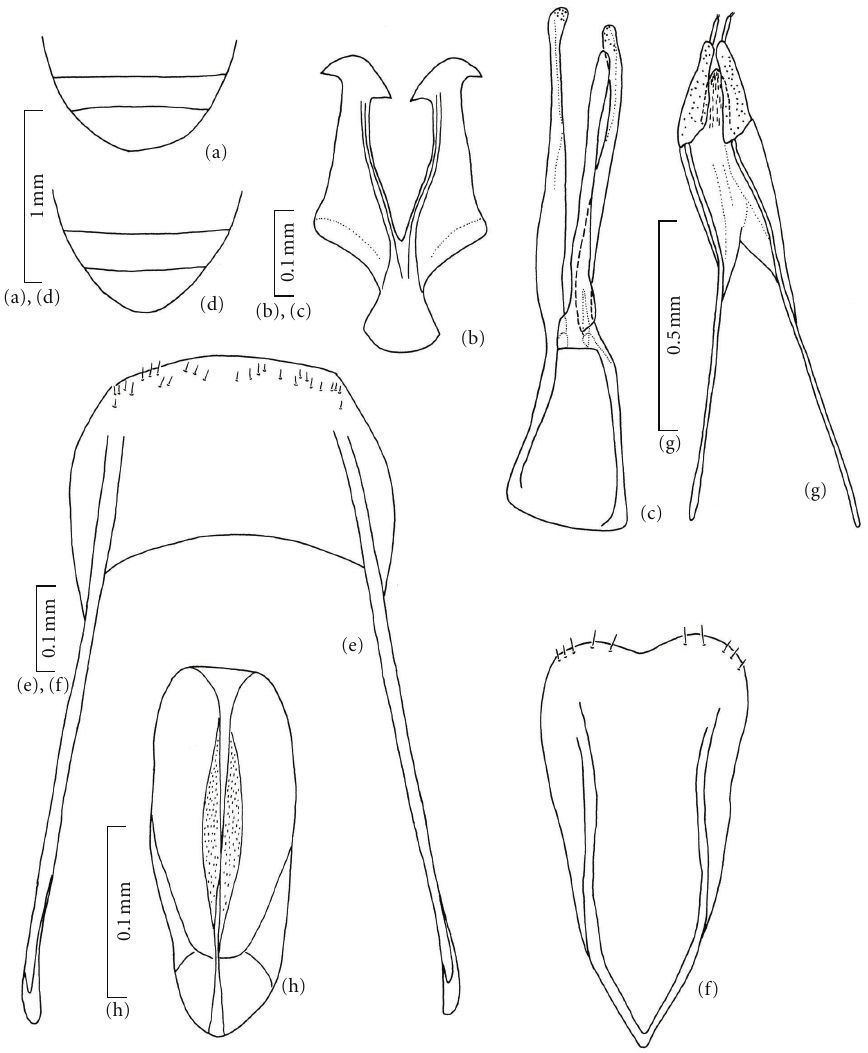
Figure 2: Hydrocyphon jogjaensis sp.n., holotype, male (a–c) and paratype, female (d–h). (a, d) Sternites V–VII; (b) tegmen; (c) penis; (e) tergite VIII; (f) sternite VIII; (g) ovipositor; (h) prehensor.